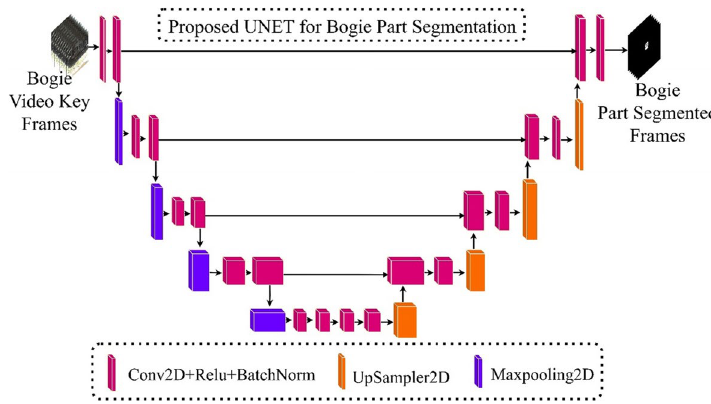
Fig. 3 The proposed UNet bogie part segmentation